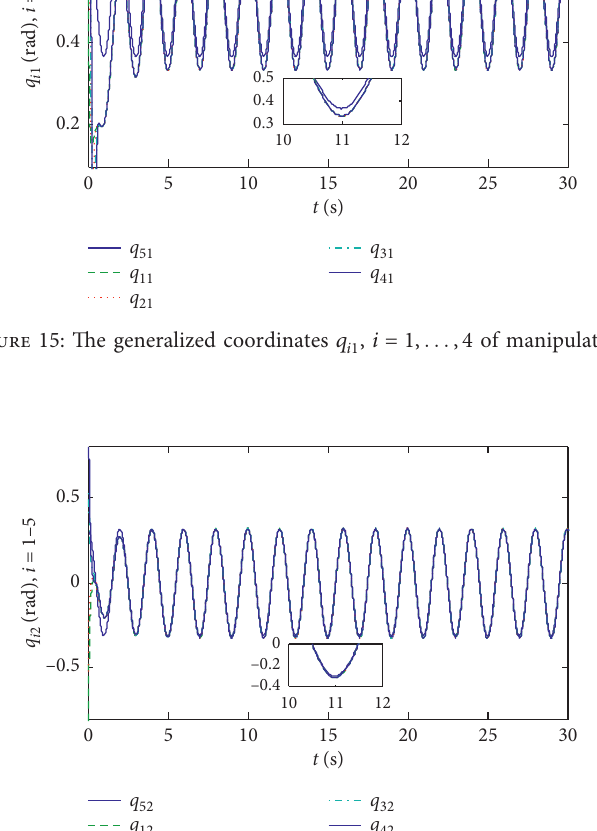
, i � 1 , ... , 4 of manipulators. i 2